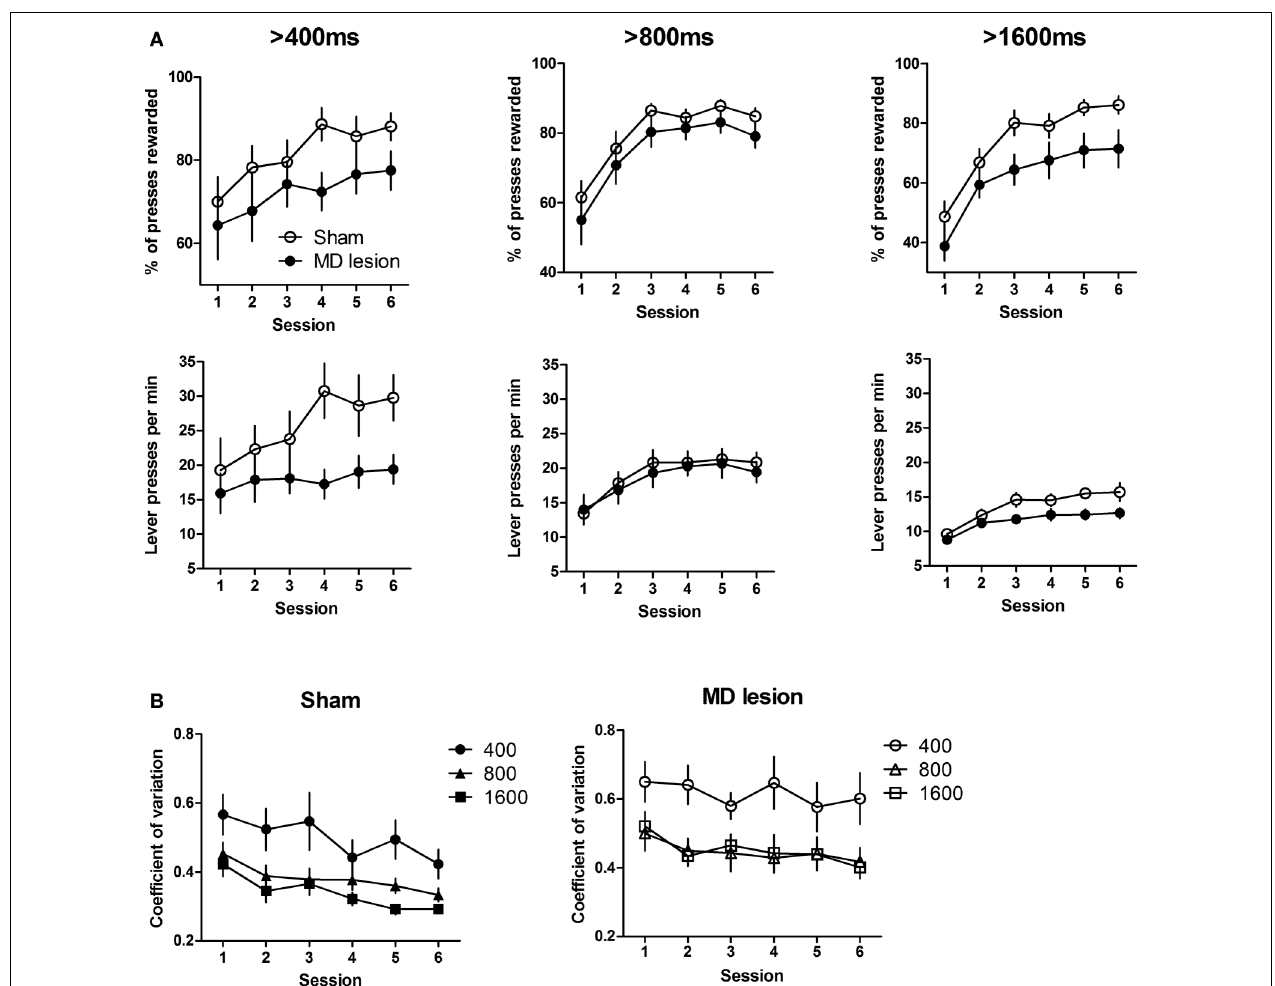
FIGURE 3 | Acquisition of duration differentiation. (A) Proportion of presses rewarded and the rate of lever pressing at each criterion duration. (B) Coeffi cient of variations of Sham (left) and MD lesion (right) at each criterion duration. Error bars indicate